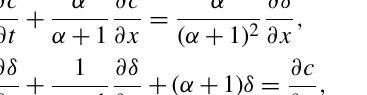
Figure 3. (a) Position, (b) variance, and (c) skewness of a plume of tracers as a function of time for α = 0.1 and α = 0.001. We com- pute the evolution of these three quantities using Eqs. (28), (33), and (38). The results agree exactly with numerical simulations. The asymptotic regimes of the skewness are represented with grey lines. Their intersection provides an estimate of the duration of the en- trainment regime (see Eq.